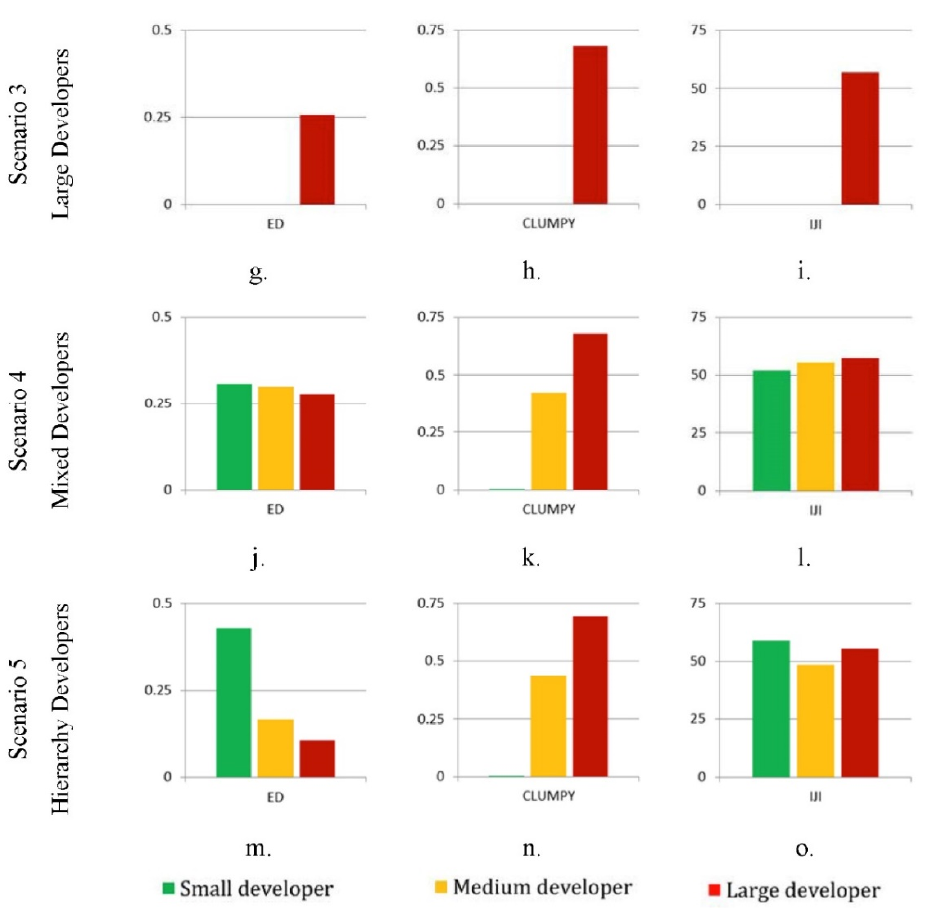
Figure 5. Landscape matrices under different scenarios.